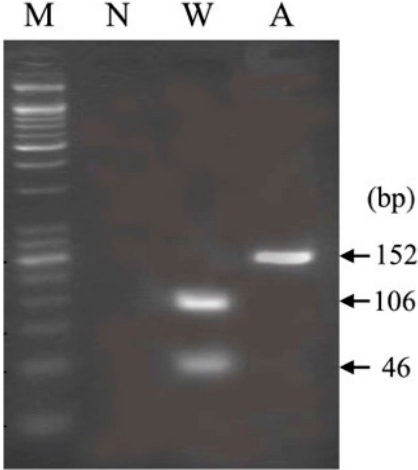
Figure 4. Genotyping of the wild-type (W) and affected (A) cats by polymerase chain reaction-restriction fragment length polymorphism using agarose gel electrophoresis. Lanes M and N show molecular size markers and non-template control, respectively.